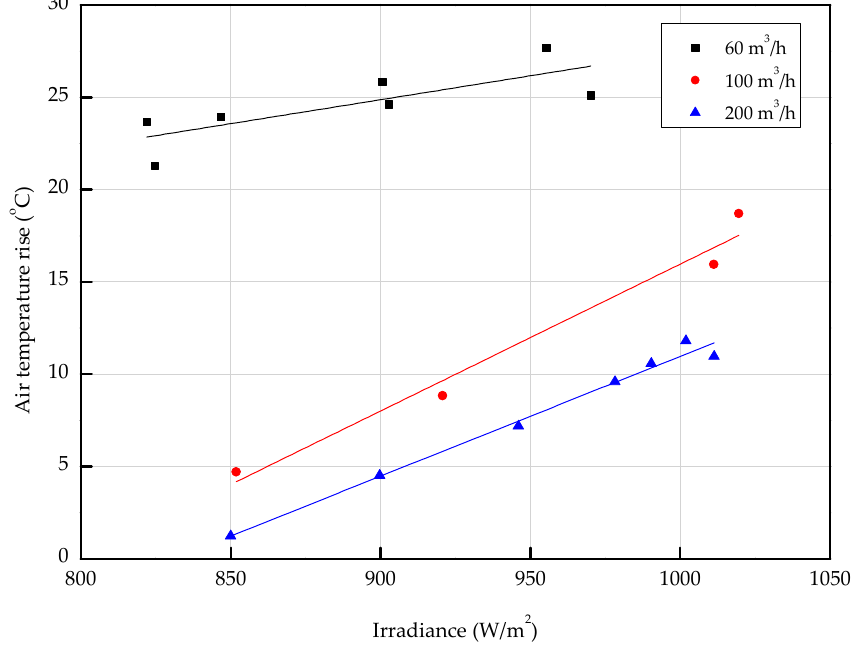
Figure 7. Effect of solar irradiance on air temperature rise between inlet and outlet for different air flow rates.